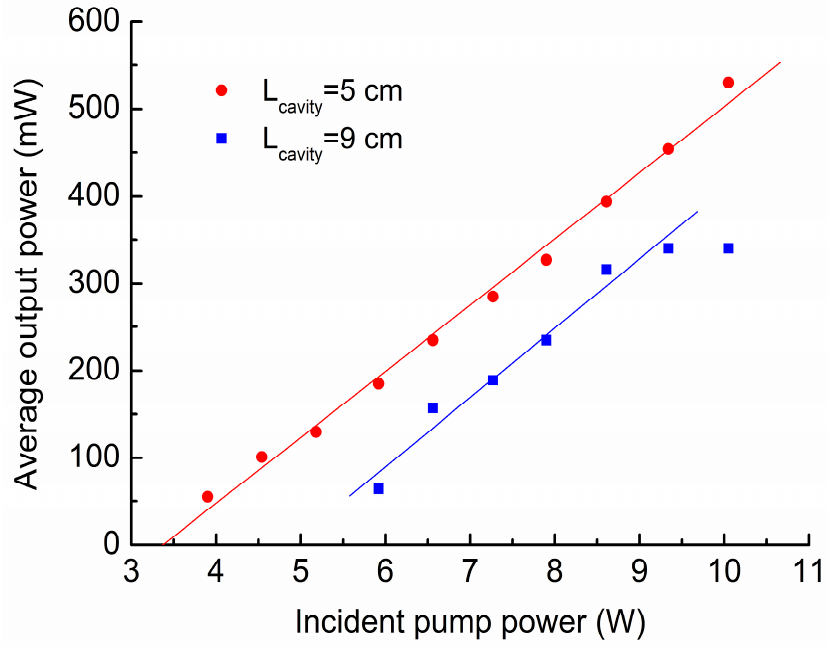
Figure 3. Average output power versus incident pump power of the Raman lasers with the cavity lengths of 5 cm and 9 cm. lengths of 5 cm and 9